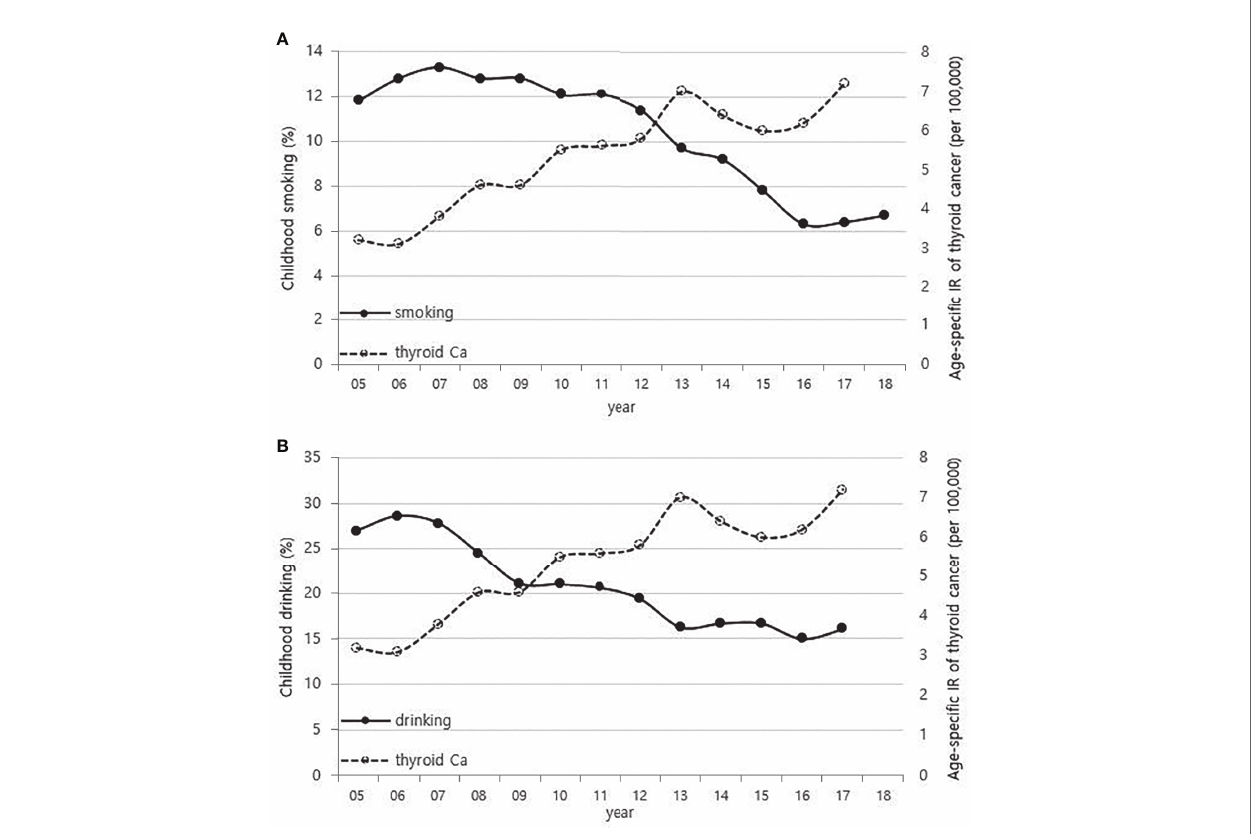
FIGURE 6 | Correlation between childhood smoking (A) and drinking (B) rates (13-18 years) (2005-2018) and age-speci fi c incidence rate of childhood thyroid cancer (0-18 years) in Korea (2005-2017, per population of 100,000). Ca, cancer; IR, incidence